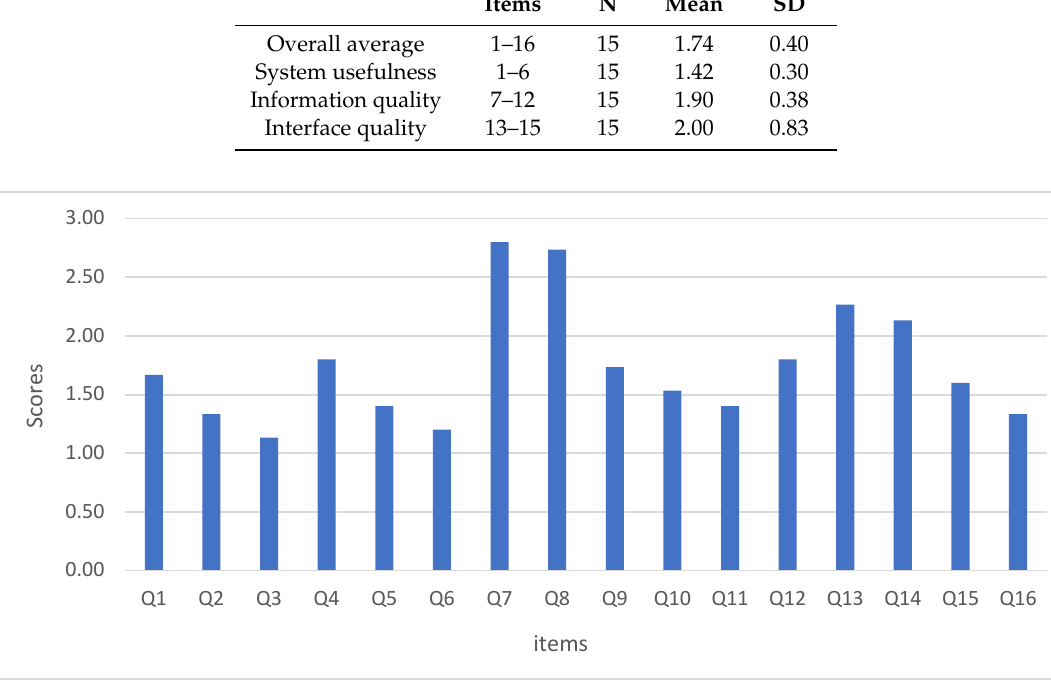
Table 1. The scores of the four items of the Post-Study System Usability Questionnaire (PSSUQ).